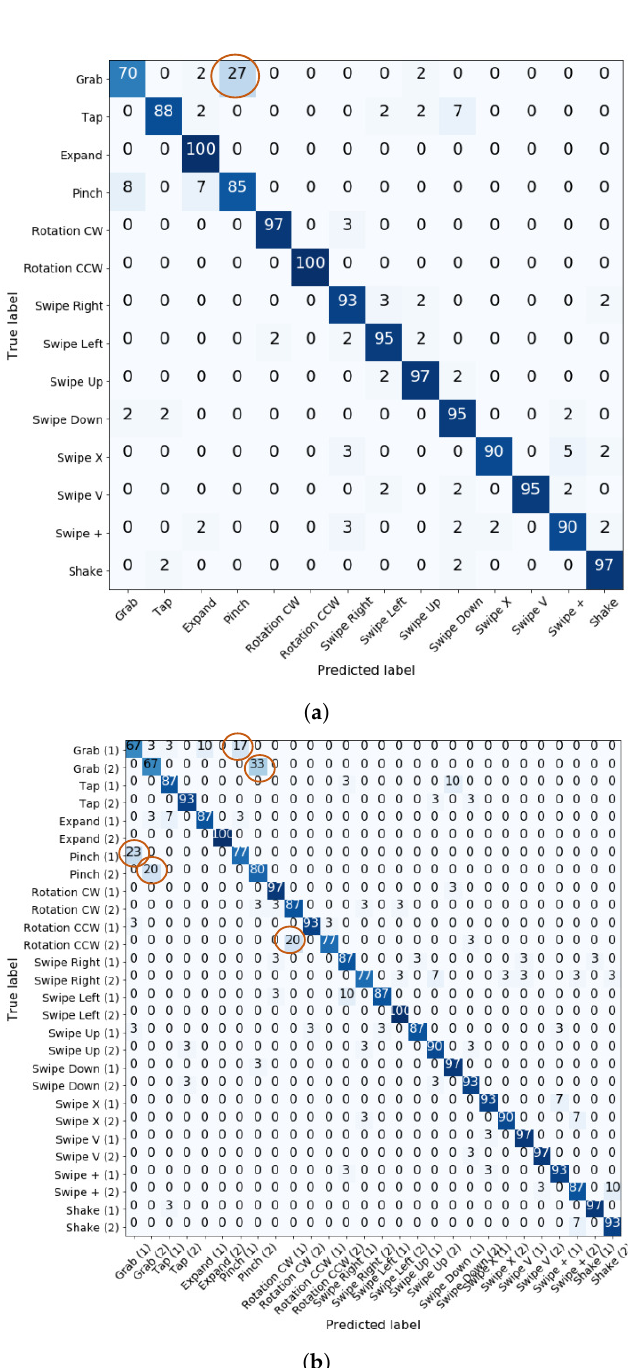
Figure 13. Confusion matrix of the best models using the singleshape feature on DHG 14 (accuracy of 92.26%) ( a ) and DHG 28 (accuracy of 88.33%) ( b ). The red circles are the false cases causing the confusion in